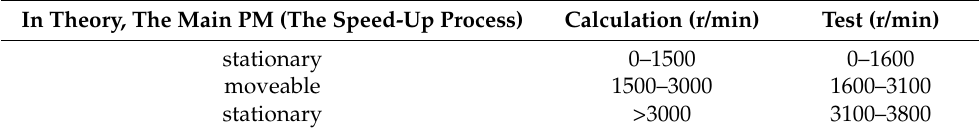
Table 2. The critical speed in the speed-up process.